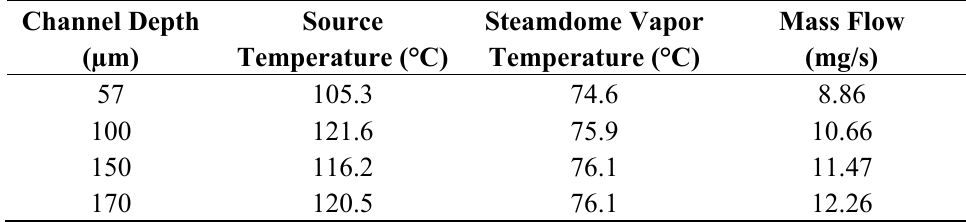
Table 2. Atmospheric boiler operation at 3.6 W thermal